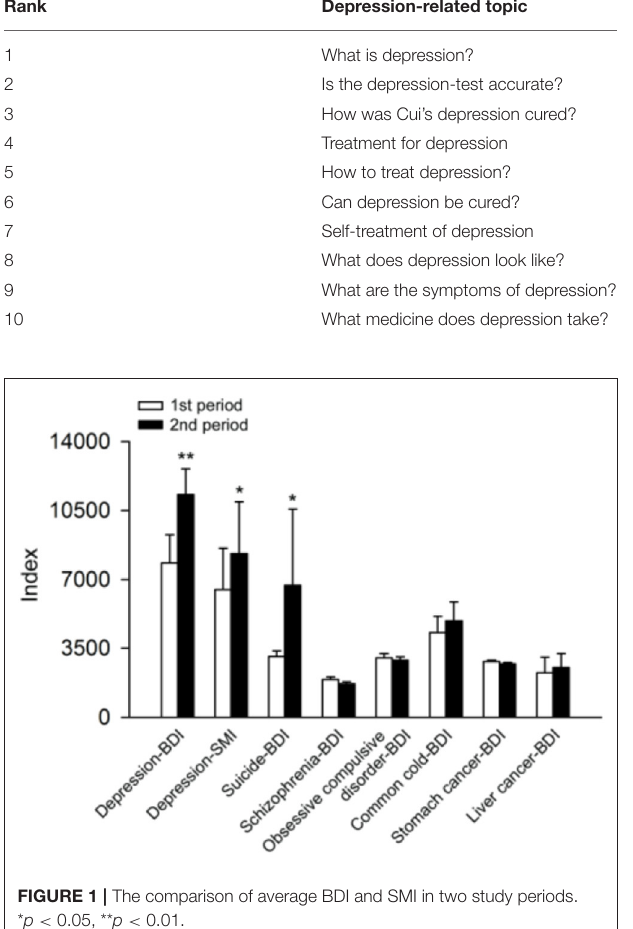
FIGURE 3 | The yearly average depression-BDI from 2012 to 2015 and average depression-BDI in two study periods. The percentage represents the growth rate relative to the previous year or